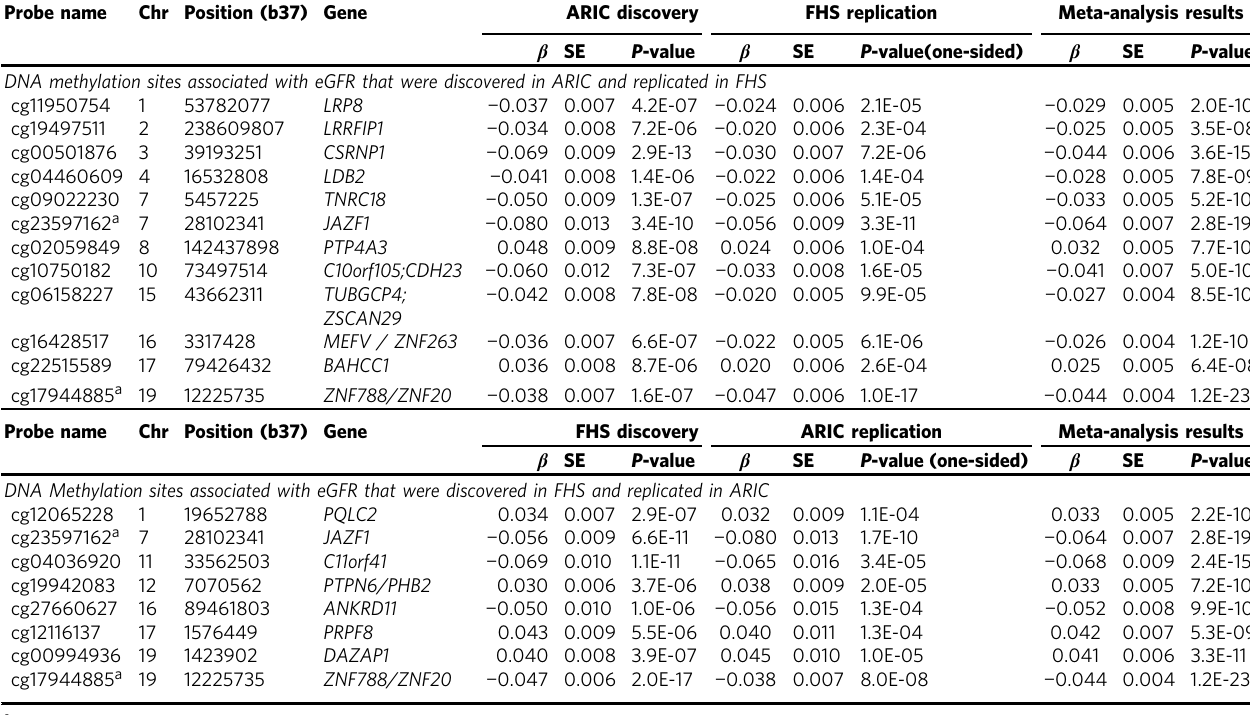
a CpG sites with P < 1e-5 in both ARIC and